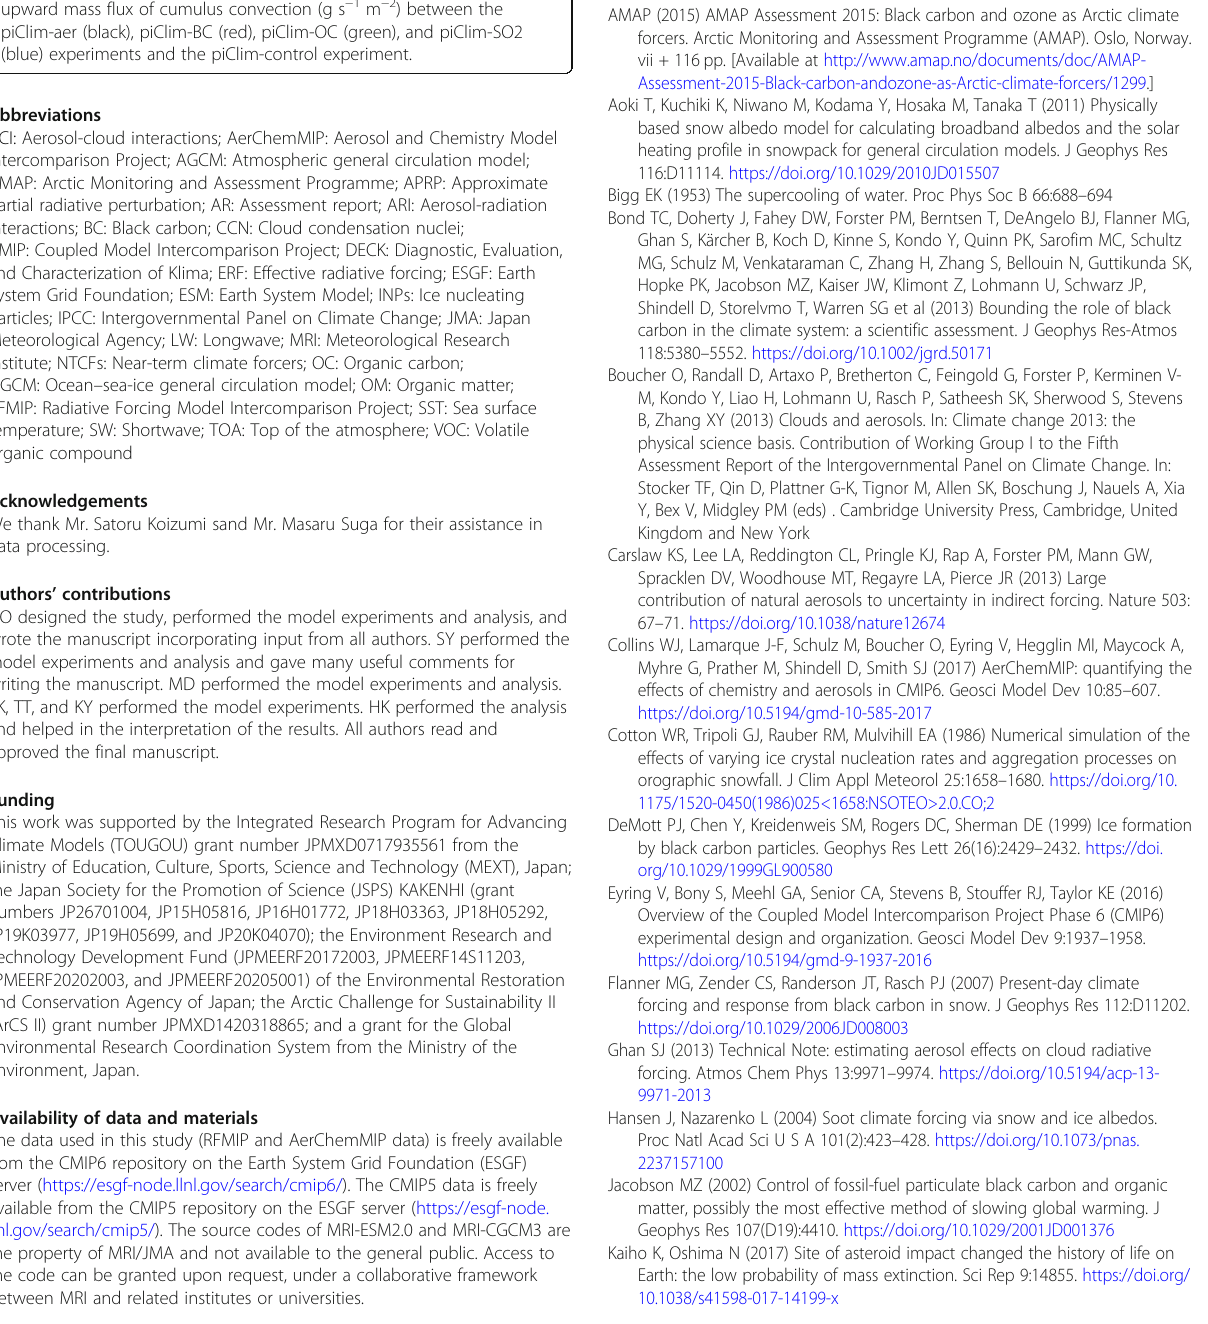
piClim-control experiment (left panels). Note that the color scales are different in each panel. Supplementary Figure 5. Horizontal distributions of the differences in the 30-year annual mean number concentrations of the aerosols averaged within the range of 150 – 420 hPa between the (a) piClim-aer, (b) piClim-BC, (c) piClim-OC, and (d) piClim-SO2 experiments and the piClim-control experiment (cm − 3 ). The thick black lines denote 30-year annual mean high-level cloud cover of 70% for the correspond- ing experiments. Note that the color scales are different in each panel. Supplementary Figure 6. Same as Supplementary Figure 5a but for boreal (a) winter, (b) spring, (c) summer, and (d) fall (cm − 3 ). Supplementary Fig- ure 7. Same as Figure 7b but for boreal (a) winter, (b) spring, (c) summer, and (d) fall (10 9 m − 2 ). Supplementary Figure 8. Vertical distributions of the differences in the 30-year annual global mean (a) temperature (K) and (b) upward mass flux of cumulus convection (g s − 1 m − 2 ) between the piClim-aer (black), piClim-BC (red), piClim-OC (green), and piClim-SO2 (blue) experiments and the piClim-control